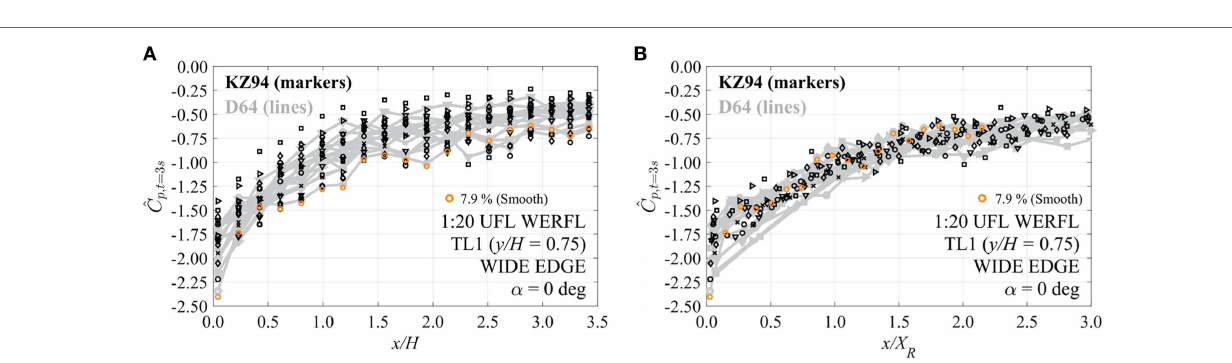
Frontiers in Built Environment |